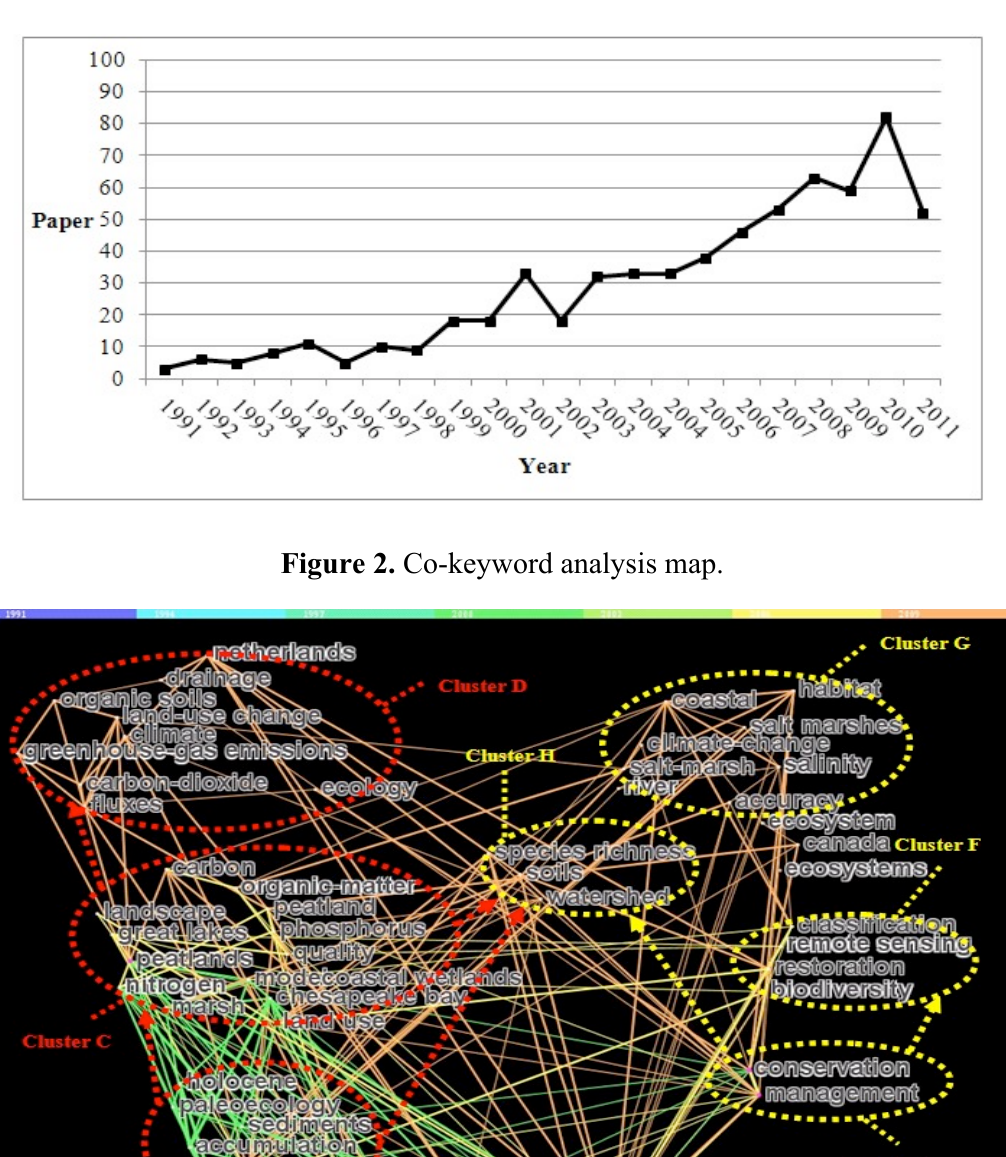
Figure 1. Number of wetland publications containing the keywords “land use” or “land cover” from 1991–2011.